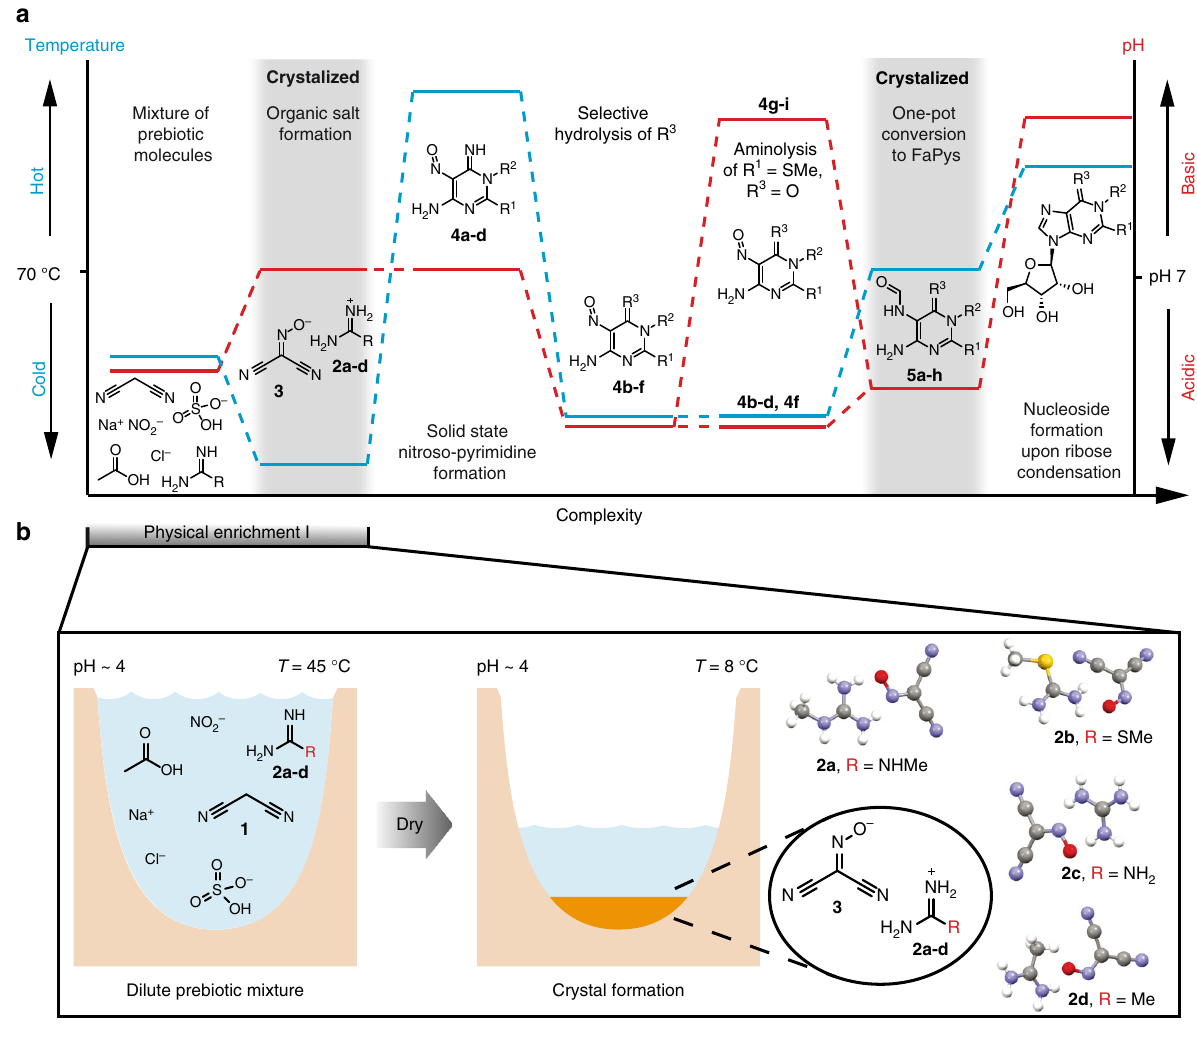
Fig. 2 Chemical complexity created by physical fl uctuations. a Relative changes of temperature (in blue) and pH (in red) are shown for each synthetic step for the continuous synthesis of purine RNA building blocks from small organic and inorganic molecules. Several wet – dry cycles establish fl uctuations of the depicted physical parameters that enable the physical enrichment of intermediates. Gray backgrounds denote compounds that are enriched by crystallization from an aqueous solution. b Formation of an organic salt consisting of amidine derivatives 2a-d and (hydroxyimino)malononitrile 3 . The salt is selectively crystalized by concentrating a dilute mixture of organic and inorganic compounds by slow evaporation. The crystal structures of the